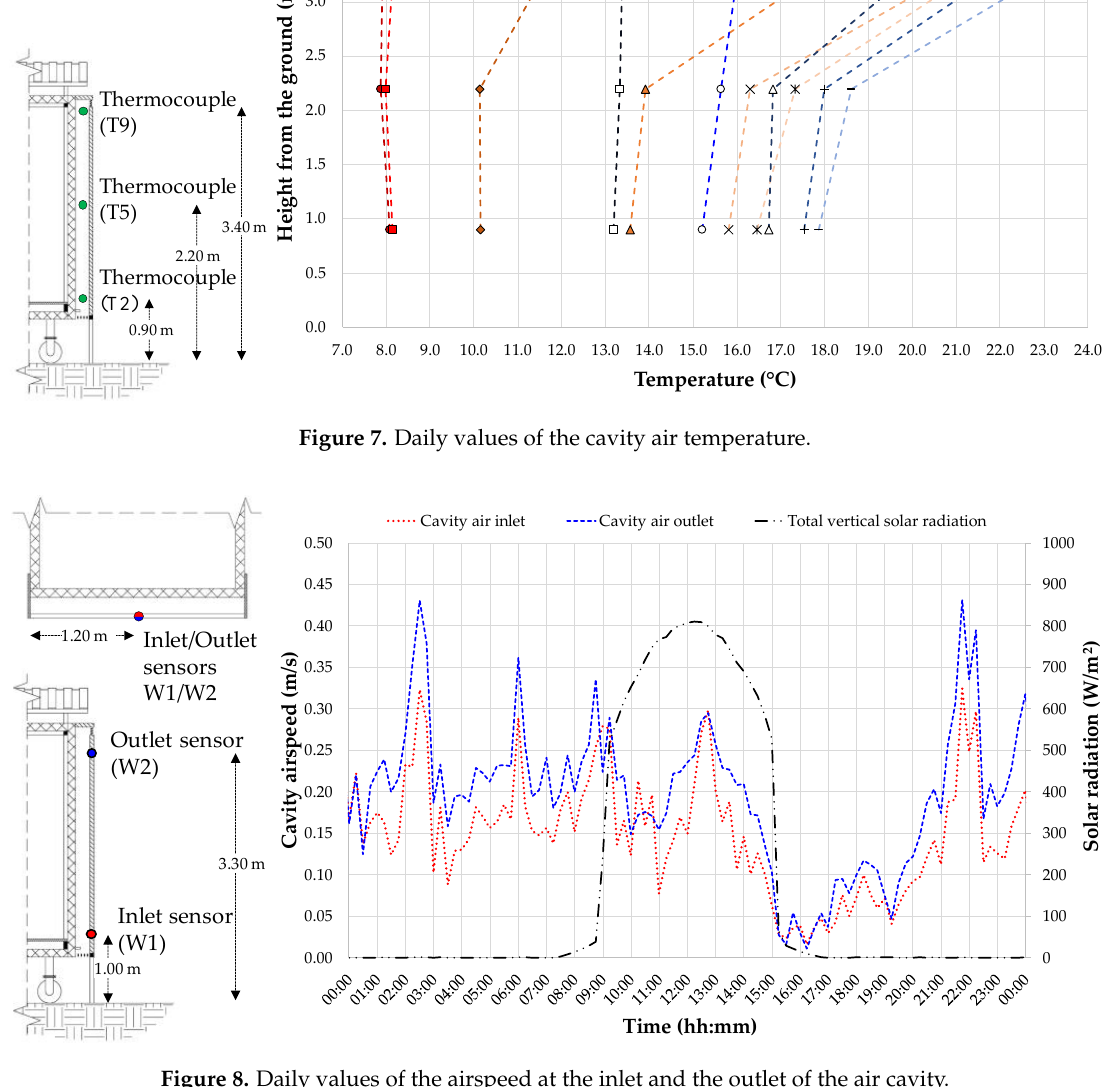
Figure 8. Daily values of the airspeed at the inlet and the outlet of the air cavity. Figure 8 reports data acquired by the hot-wire anemometers placed based on the layout shown in Figure 2a, where W in measured the airspeed value at the inlet of the cavity and W out measured the value at the outlet of the cavity. This figure shows how, during the day, the values acquired by W out is higher than those measured by W in , referable to a direct effect of the solar radiation on the rising of the air temperatures along the air cavity, thus causing an increase in airspeed. After 15:00, the chimney effect in the air cavity is reduced because the temperatures are gradually decreasing over time due to the reduction of the solar radiation on the south facade; this causes a significant drop in the airspeed values measured in the cavity. Therefore, the analysis of the experimental results shows that a plastic material (i.e., ABS) can be used as a second-skin layer in OVF